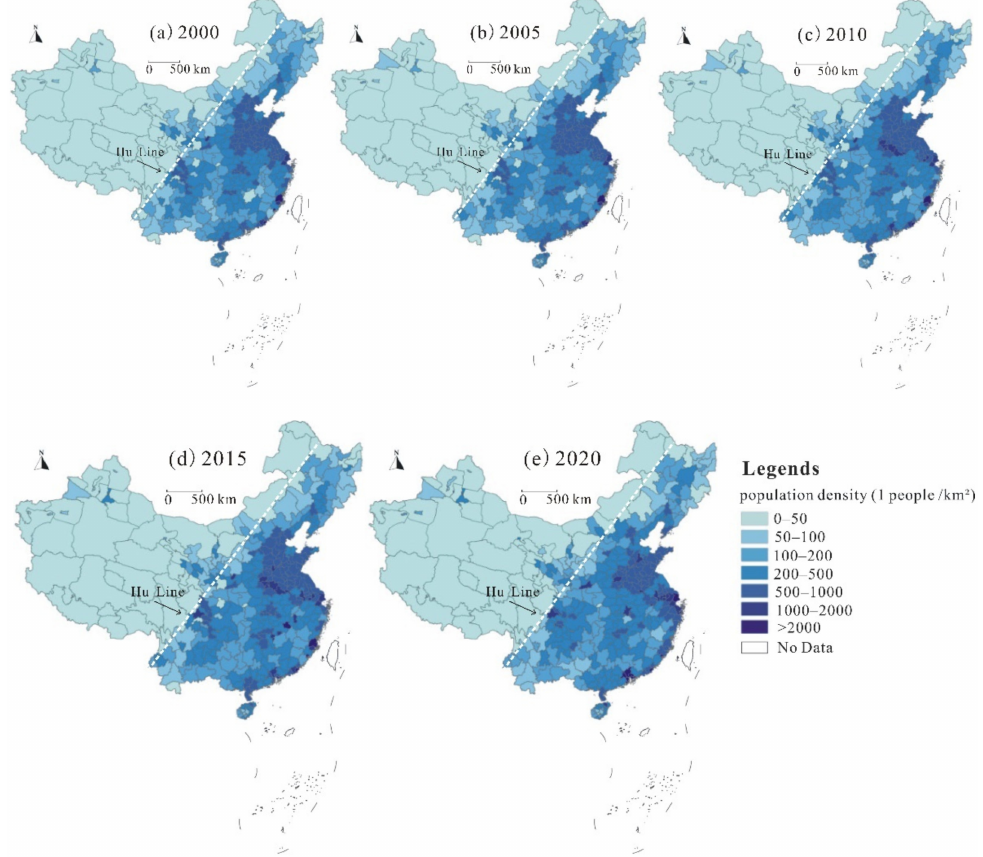
Figure 2. Spatial distribution characteristics of population density (PD) in Chinese Mainland during the investigation